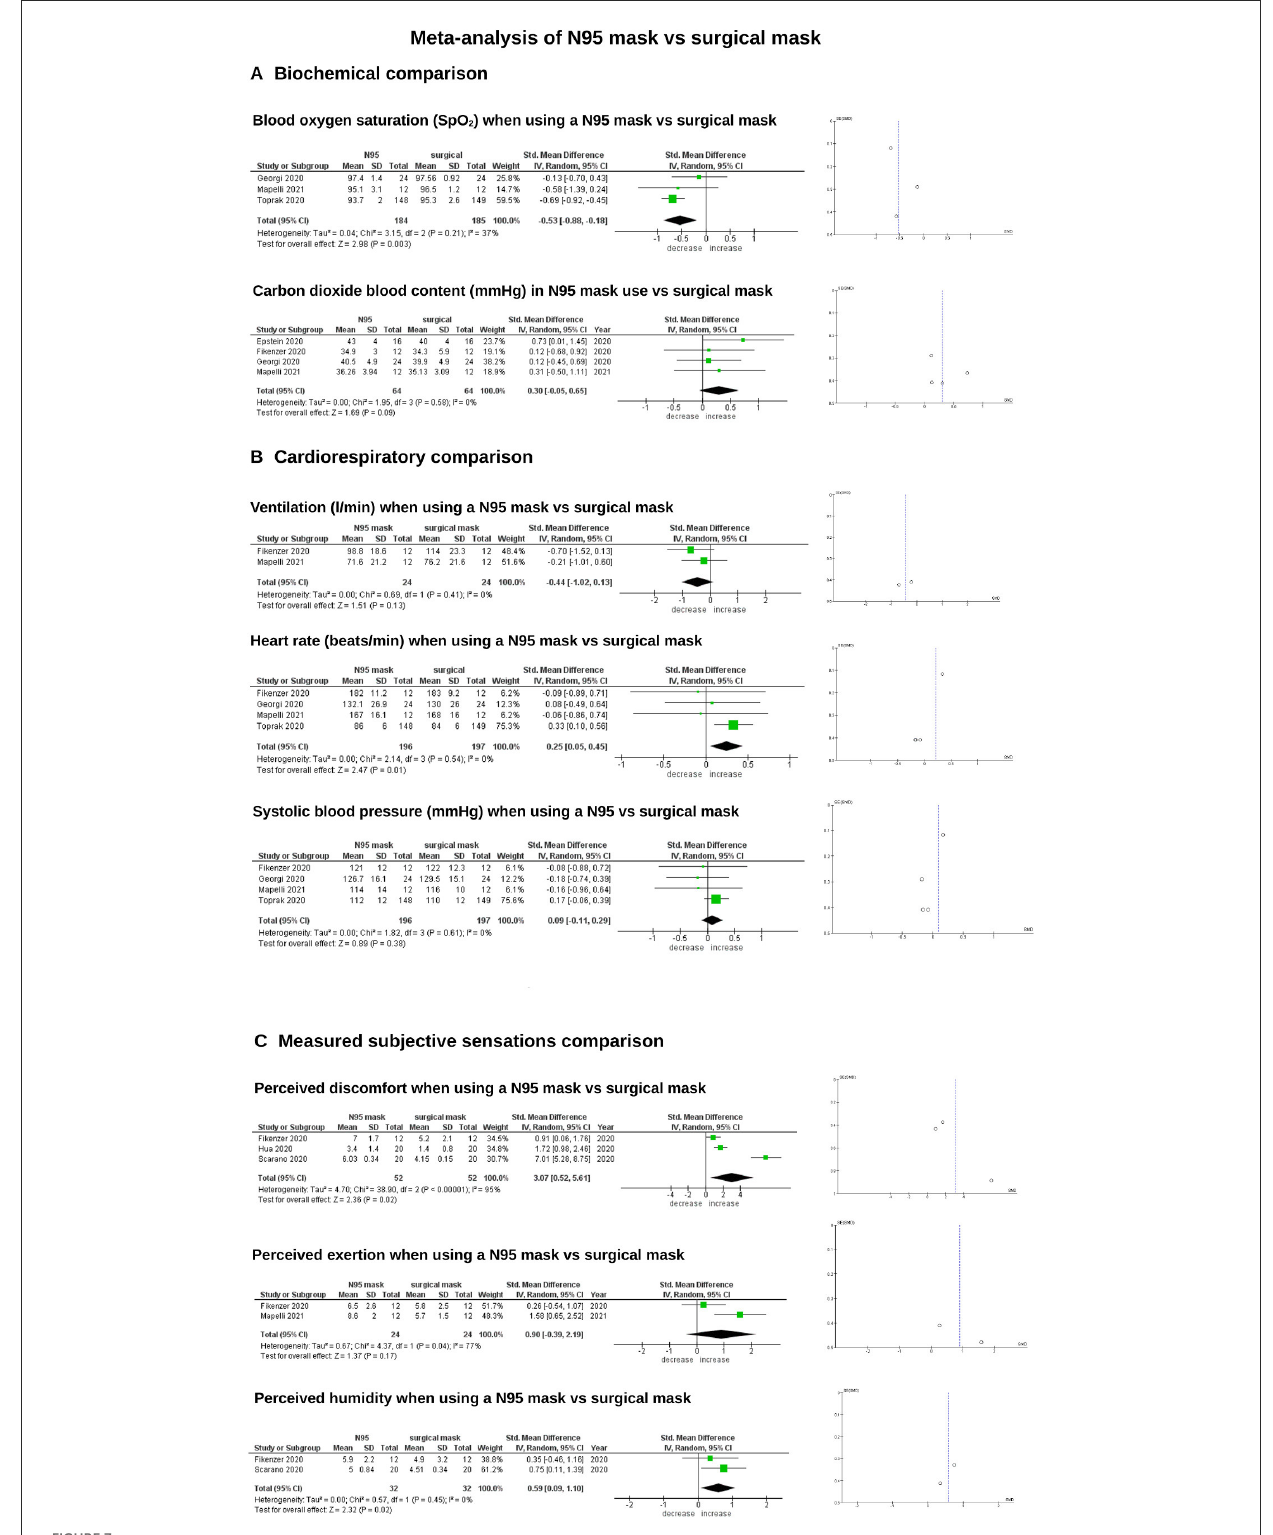
FIGURE7 Results comparing the N95 to the surgical mask in the meta-analysis. Forest (left) and funnel plots (right) of meta-analysis of diverse outcomes while wearing a N95 mask vs surgical mask are shown. (A) Depicts the biochemical, (B) the cardiorespiratory outcomes, and (C) the subjective sensations outcomes. N95 mask leads to measurably less favorable results compared to the surgical mask, significantly for oxygenation (decrease), heart rate (increase), discomfort and humidity (both increases). This trend was also evident for minute volume (decrease), CO 2 and systolic blood pressure (both increases), but in those comparisons not statistically significant due to too few includable